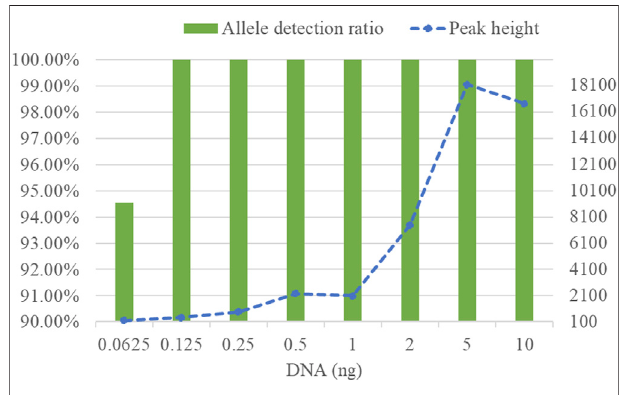
FIGURE 3 | Allele detection ratios and allelic peak height of the STRtyper-27 comp kit at different amounts of DNA